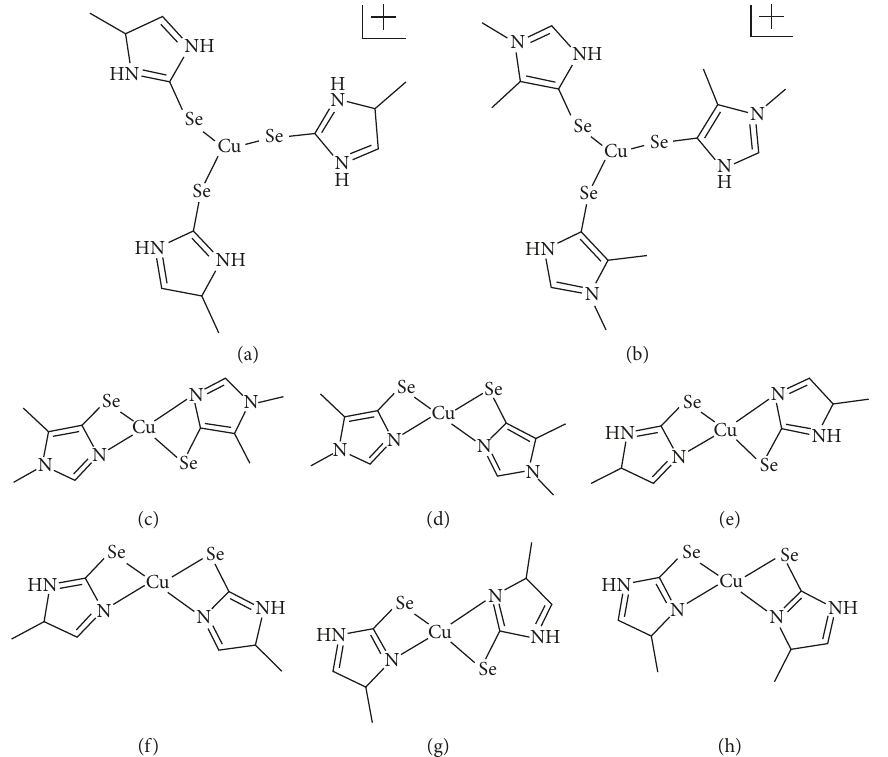
Figure 1: Schematic illustration of possible complexes formed by ligation of 4-selenol-N 1 -methyl-5-methylimidazole (OSeH) or 2-selenone-4-methylimidazole (ESeH) to Cu(I) and